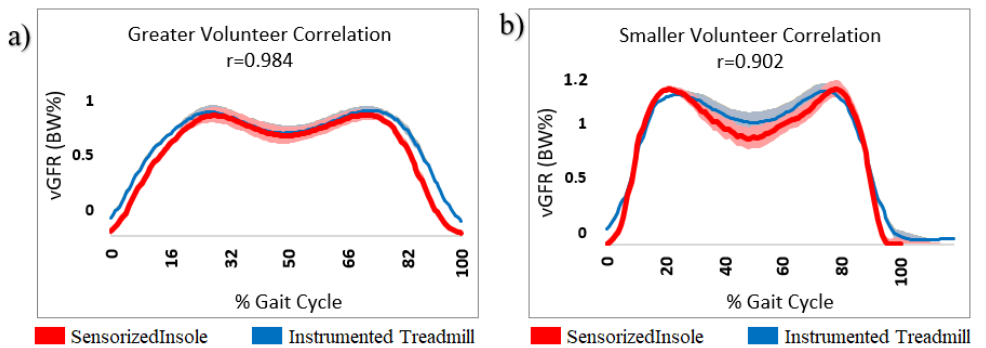
Figure 5. vGRF normalized curves dividing by maximum value during 1-min walk using the sensorized insole (red line) and the force plate (blue line) as reference. The shadows are the respective standard deviations. ( a ) Greater correlation sample and ( b ) smaller correlation sample. r: Pearson correlation coefficient.